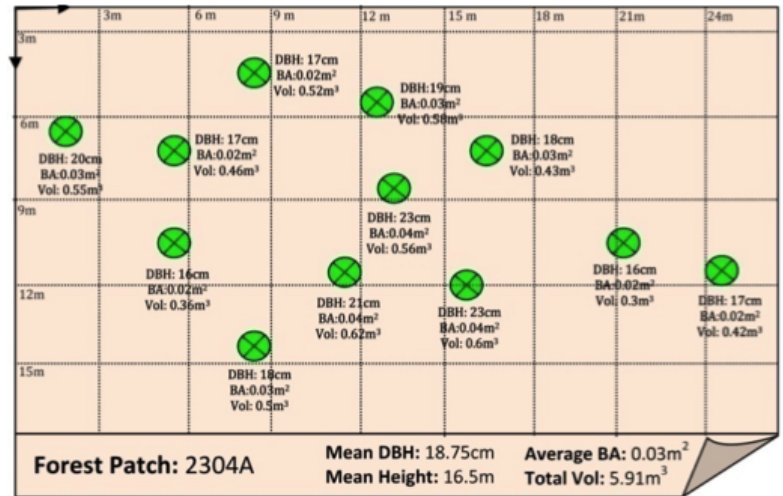
Figure 10. Generated map of a forest patch with different estimated